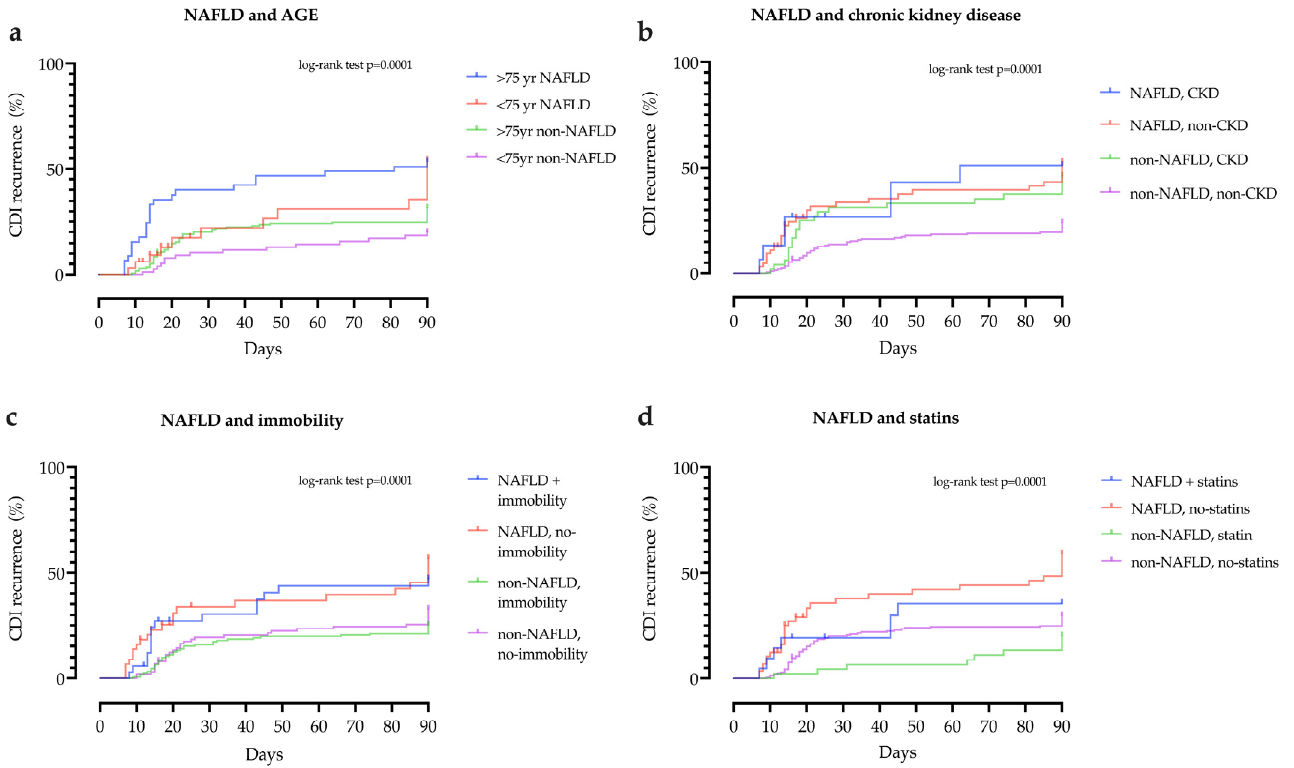
Figure 2. Kaplan–Meier curves for recurrence of Clostridioides difficile infection (CDI). Using the Kaplan–Meier method, a proportion of patients with CDI recurrence stratified by the concomitant presence of NAFLD and ( a ) age, ( b ) chronic kidney disease, ( c ) immobility and ( d ) statins during the follow-up period.